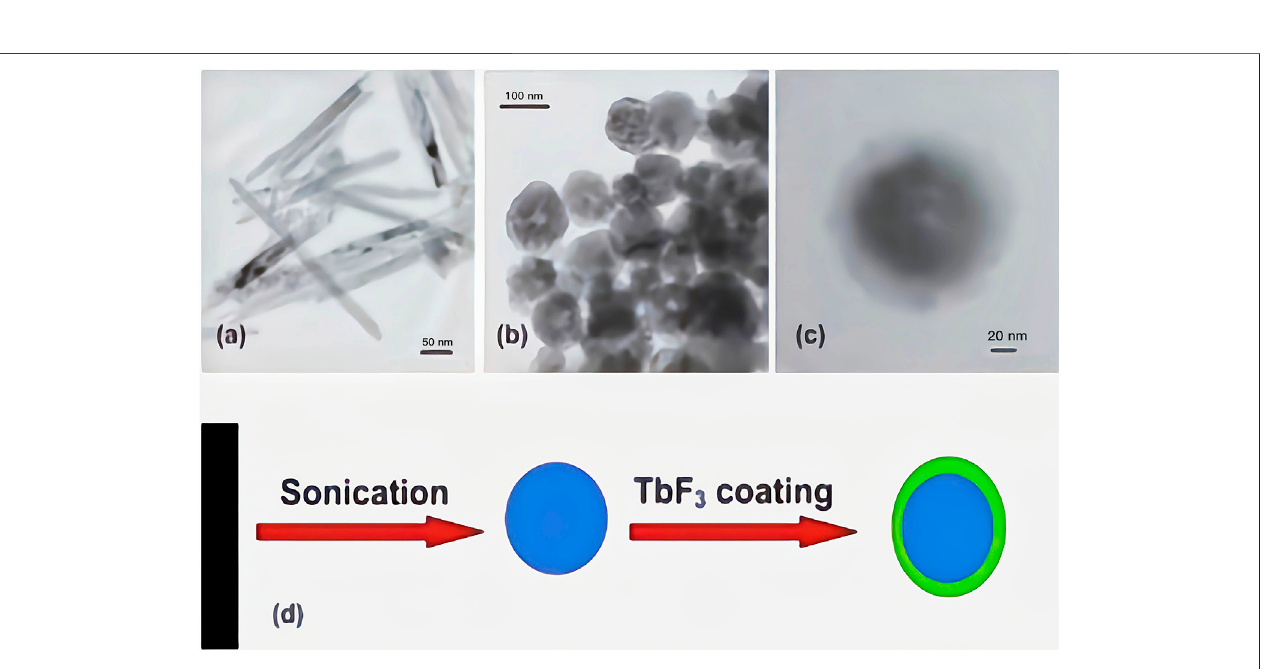
Frontiers in Chemistry |